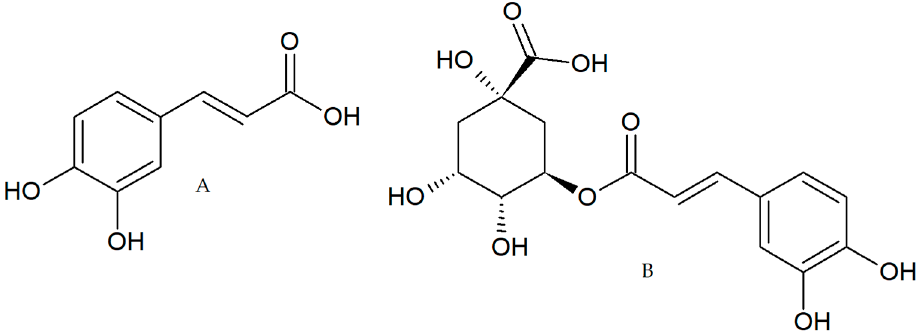
Figure 1. Caffeic acid, CA ( A ) chlorogenic acid, CGA ( B ).